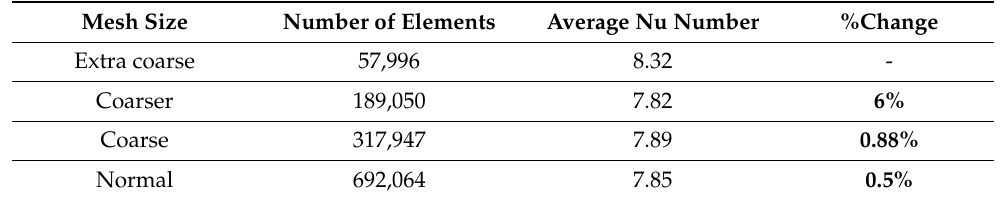
Table 2. Mesh analysis.